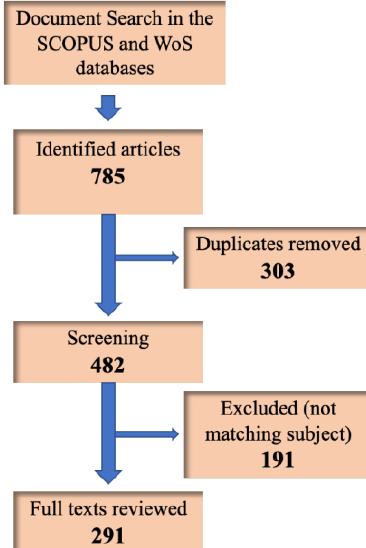
Figure 1. Search process. Source: Authors’ o wn elaboration.